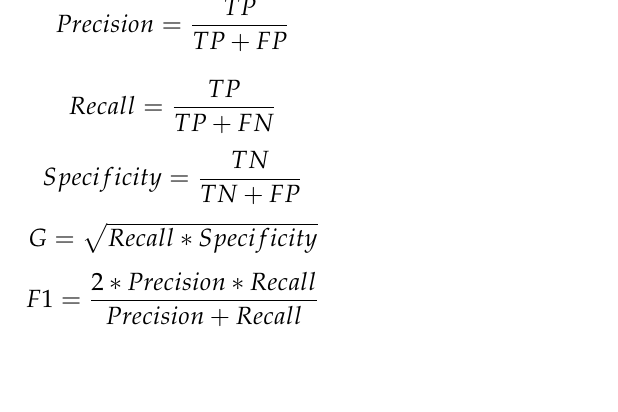
Table 3. The confusion